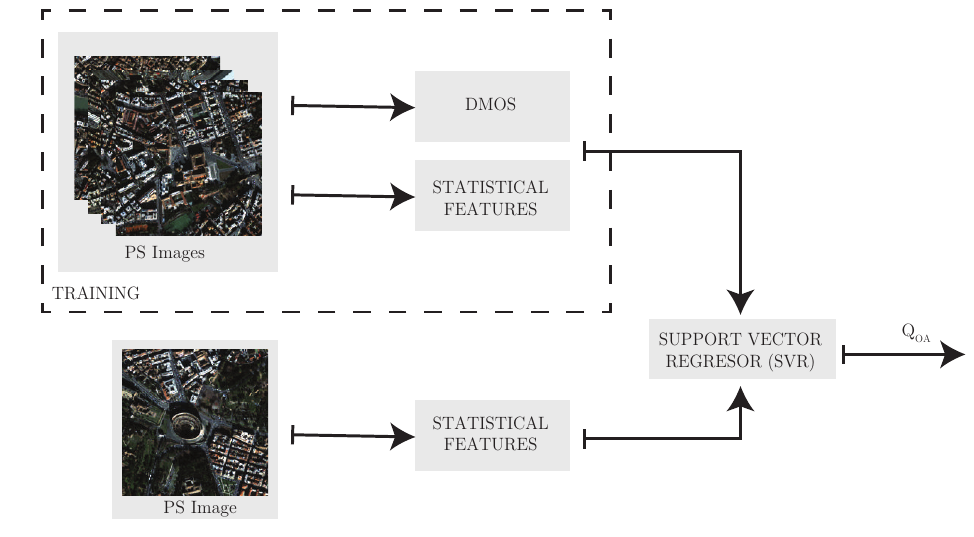
Figure 6. Flow chart of the ODAquality